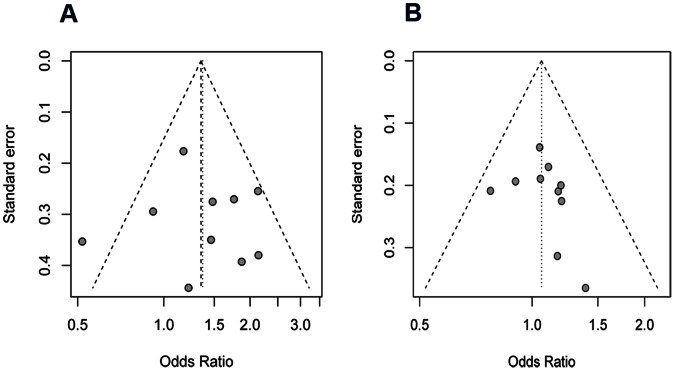
Begg’s funnel plot with 95% confidence limits (CIs) of publication bias test.(A). recessive model; (B). dominant model.